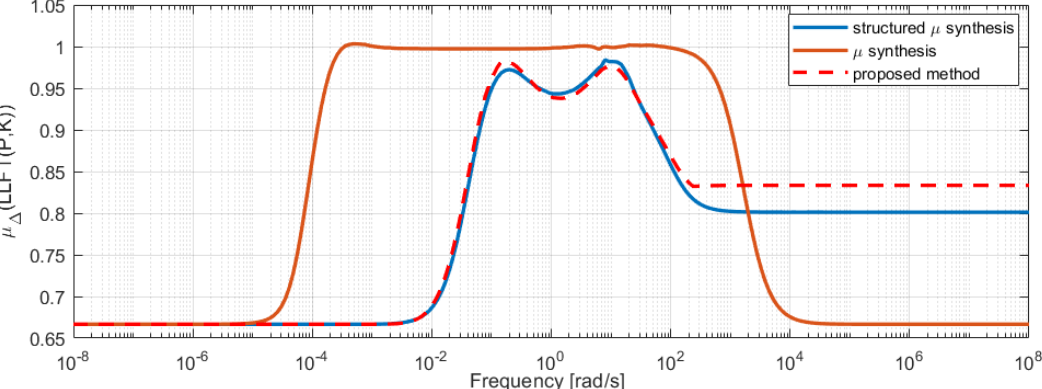
Figure 7. Comparison between structured singular values’ frequency response obtained with the structured µ -synthesis from MATLAB (blue), with the unstructured µ -synthesis from MATLAB (orange) and with the proposed method (red), respectively.